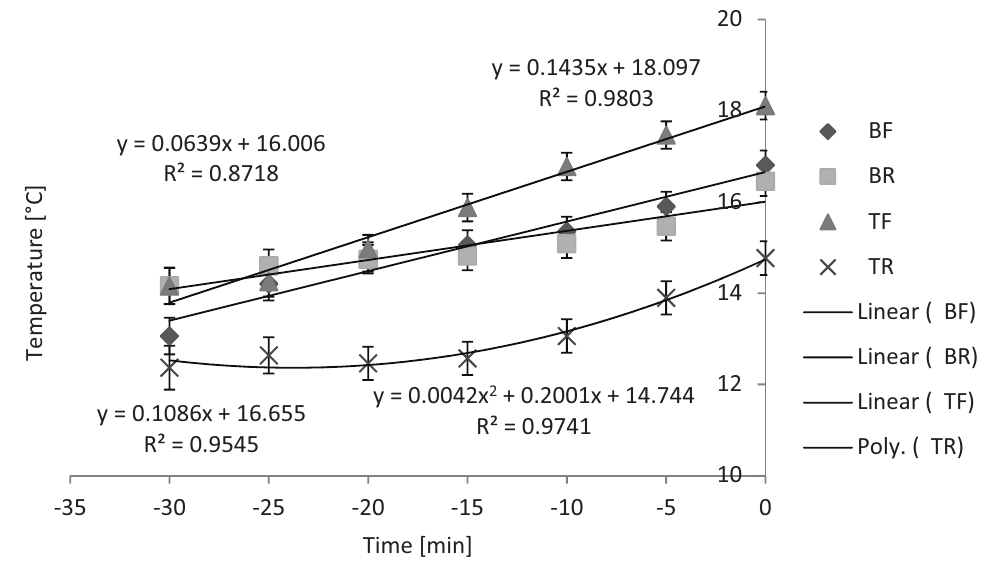
BF = bottom front, BR = bottom rear, TF = top front, TR = top rear compartments.